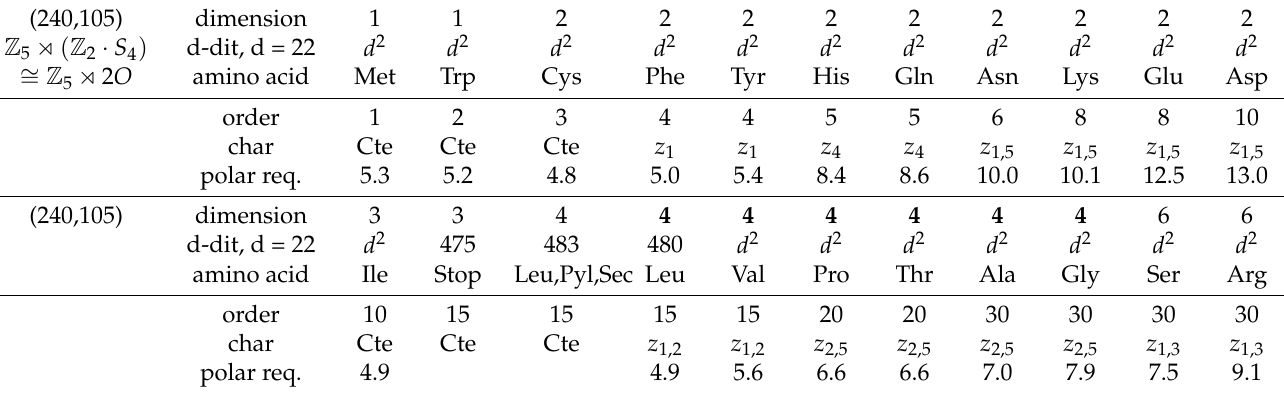
Table A1. For the group G 5 : = ( 240,105 ) ∼ = Z 5 (cid:111) 2 O , the table provides the dimension of the representation, the rank of the Gram matrix obtained under the action of the 22 -dimensional Pauli group, the order of a group element in the class, the entries involved in the character and a good assignment to an amino acid according to its polar requirement value. Bold characters are for faithful representations. There is an ‘exception’ for the assignment of the sextet ‘Leu’ that is assumed to occupy two 4-dimensional slots. All characters are informationally complete except for the ones assigned to ‘Stop’, ‘Leu’, ‘Pyl’ and ‘Sec’. The notation in the entries is as follows: z 1 = − ( z 5 = − 2cos ( π /15 ) , compare [Table 7] of